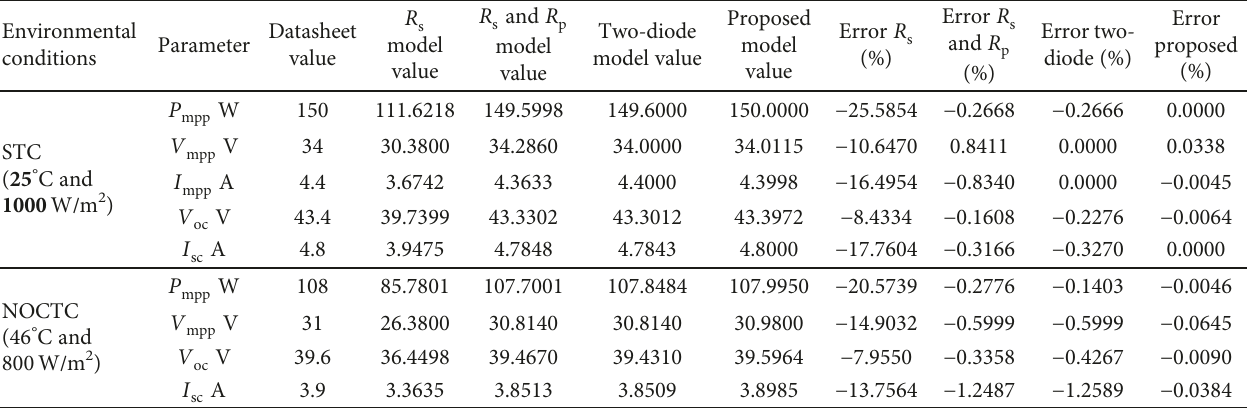
Table 5: Comparison of R SQ 150-PC PV module